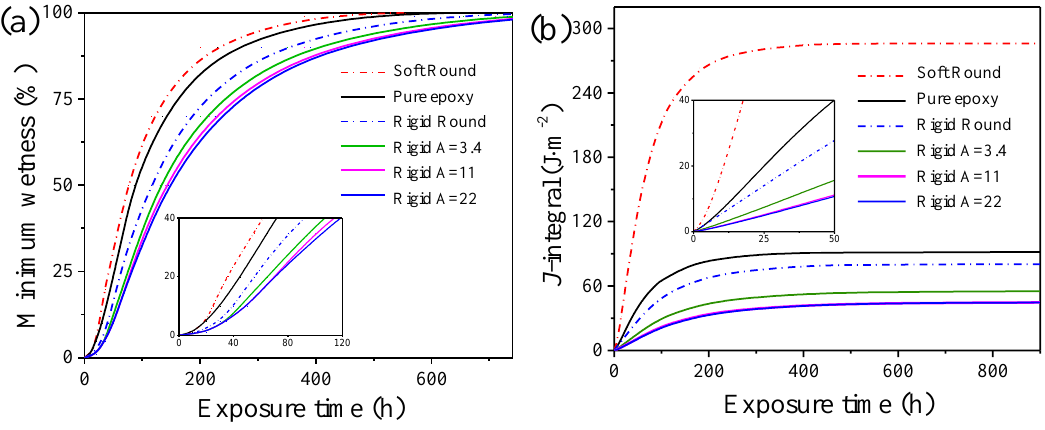
Figure 13. Effect of fillers on ( a ) moisture diffusion and ( b ) J i values.